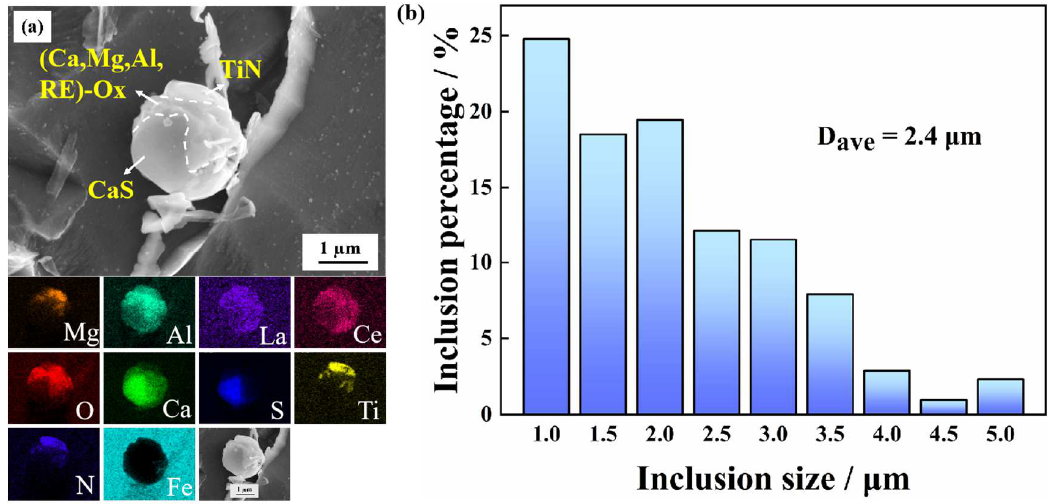
Figure 2. ( a ) SEM-EDS mapping images and ( b ) equivalent size distribution of inclusions.